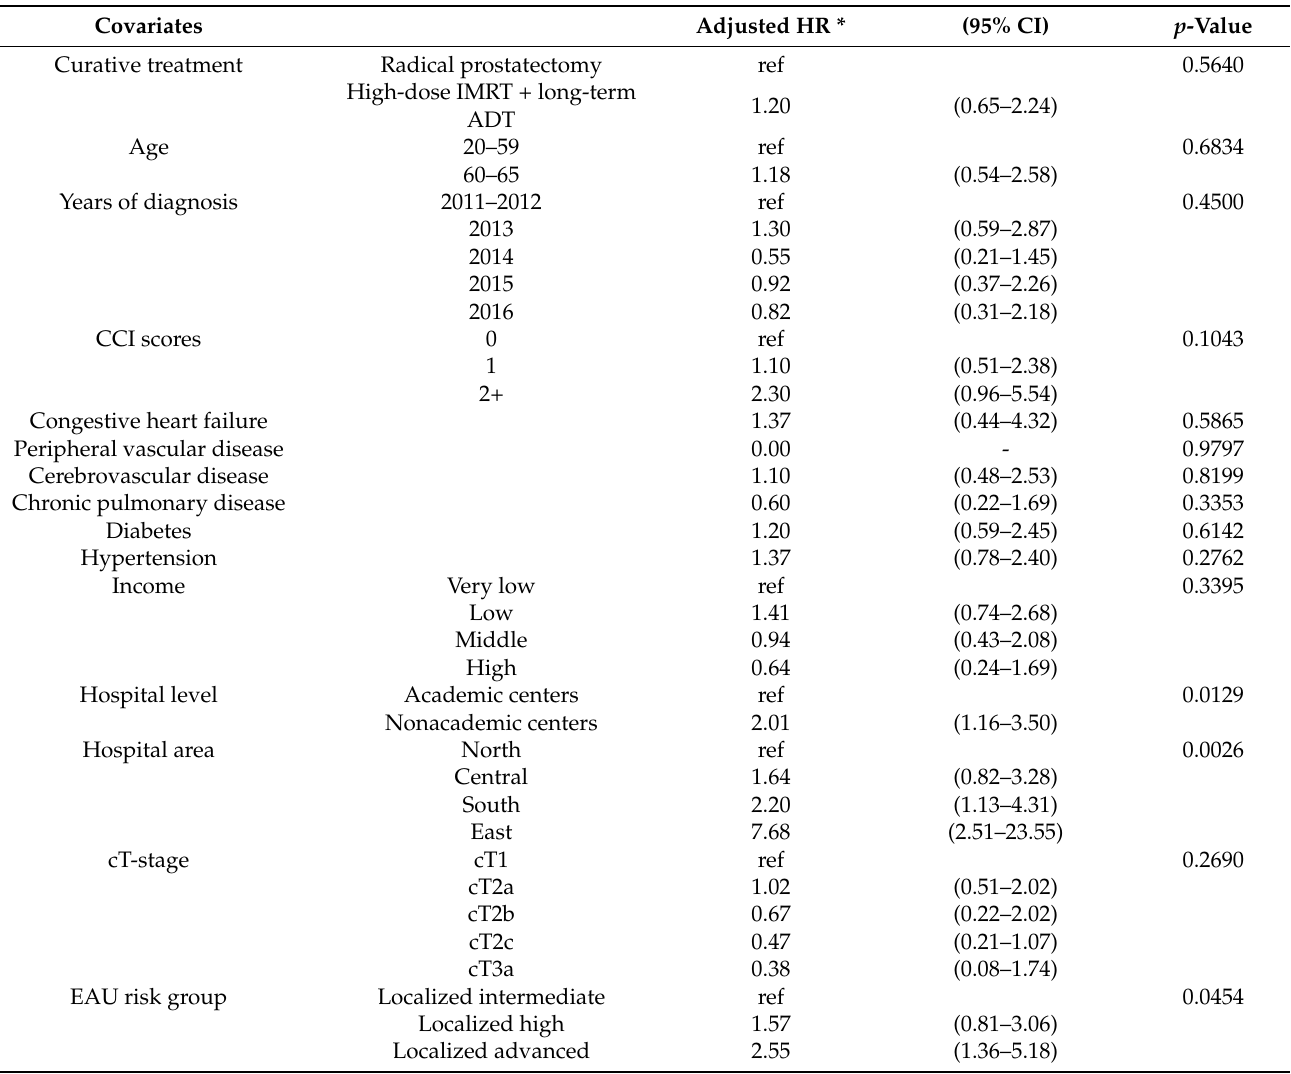
Table 2. Multivariate Cox proportional hazards regression analysis of all-cause death of young patients with high- to very high-risk prostate